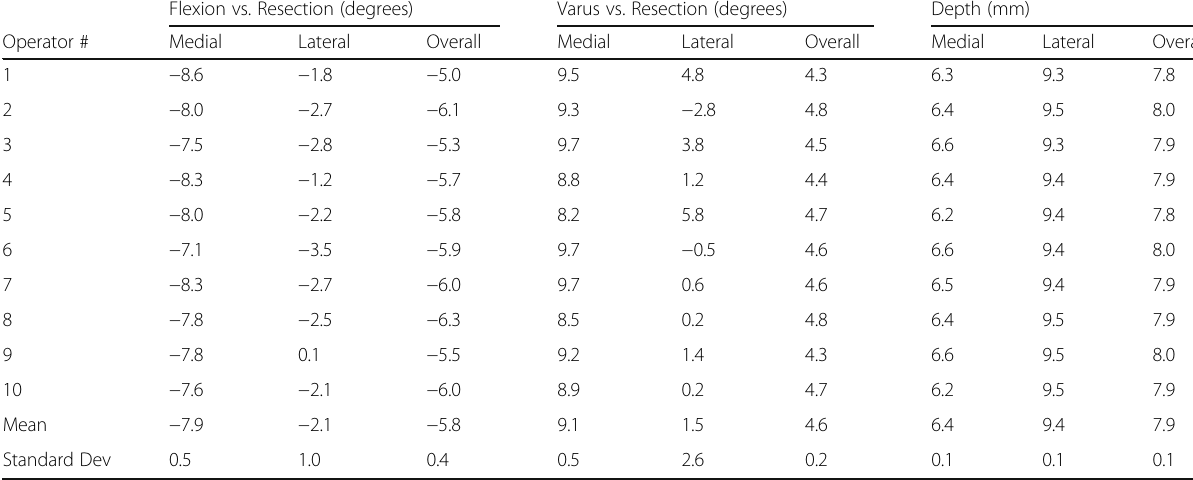
Table 3 Plane repeatability study for point selection process for single operator Flexion vs. Resection